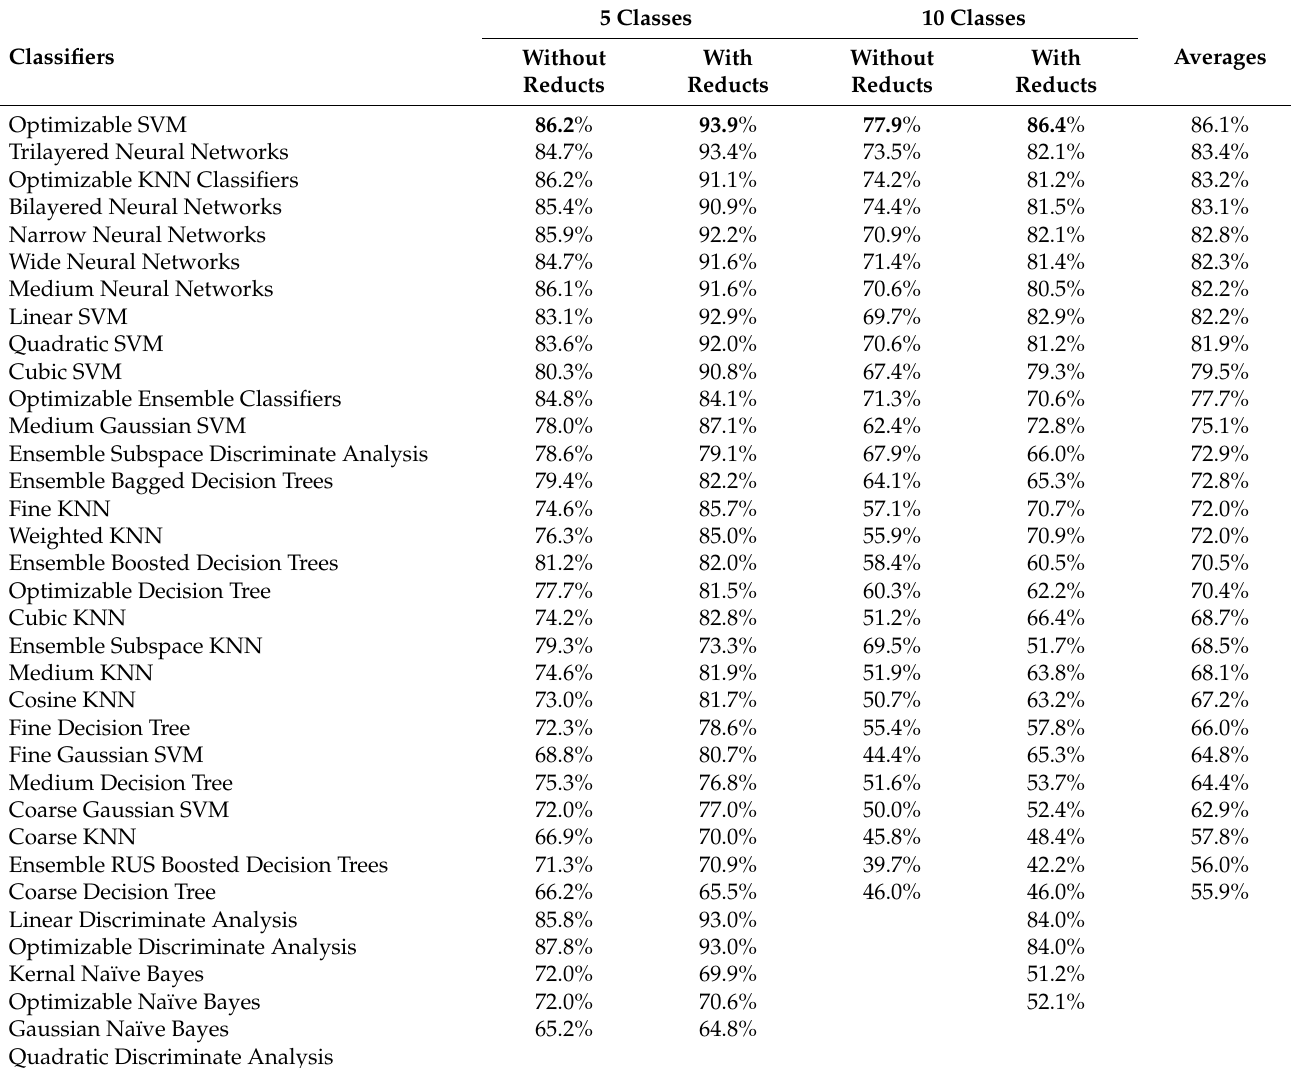
Table 7. Class prediction rates of the QU